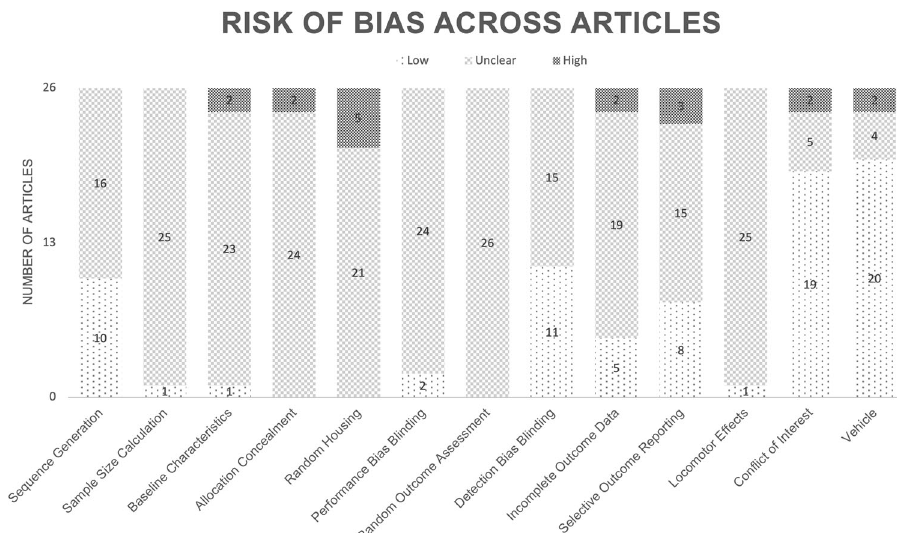
Fig. 7 Evaluation of included articles. Aside from the con fl ict of interest statement and vehicle measures, an unclear risk of bias is the most common evaluation score across all